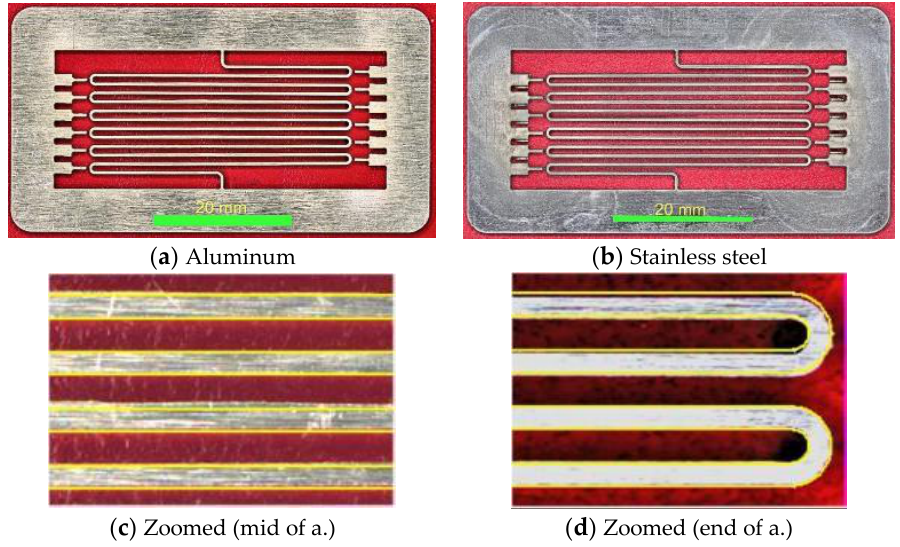
Figure 4. Metal flexures – 5555 JMC (CBA).